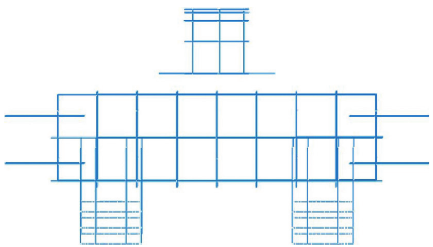
Figure 18: Reinforcement diagram of MT-1.